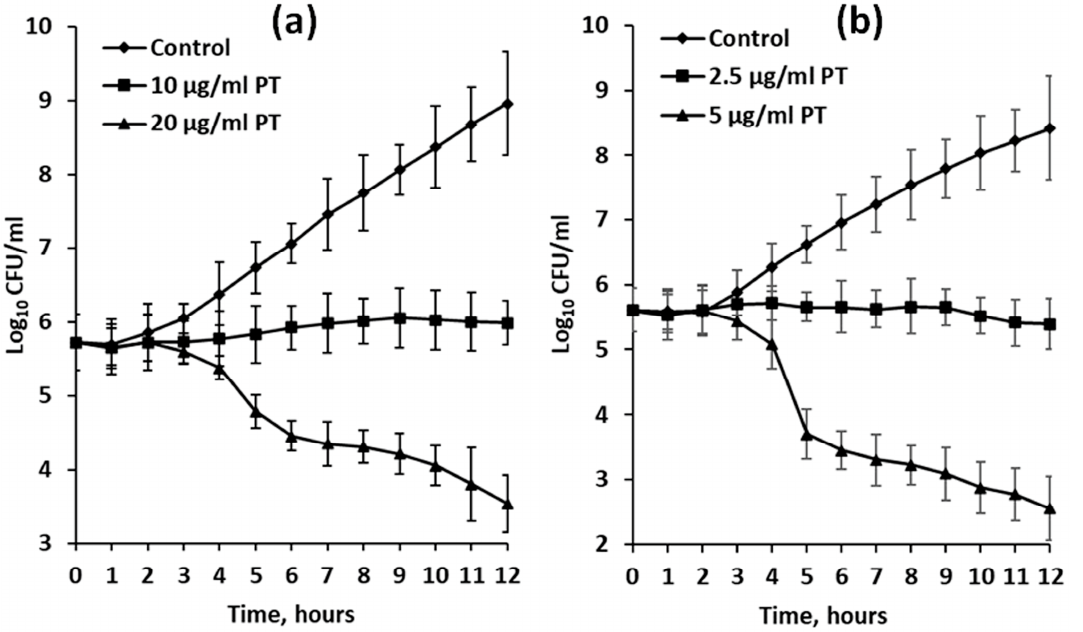
Figure 4. Growth curves of Escherichia coli cultures in VB medium (control) or VB medium supple- mented with phlorotannin-enriched extracts (PT) of Fucus serratus ( a ) and Desmarestia aculeata ( b ). Means are given with ±SD ( n = 4).